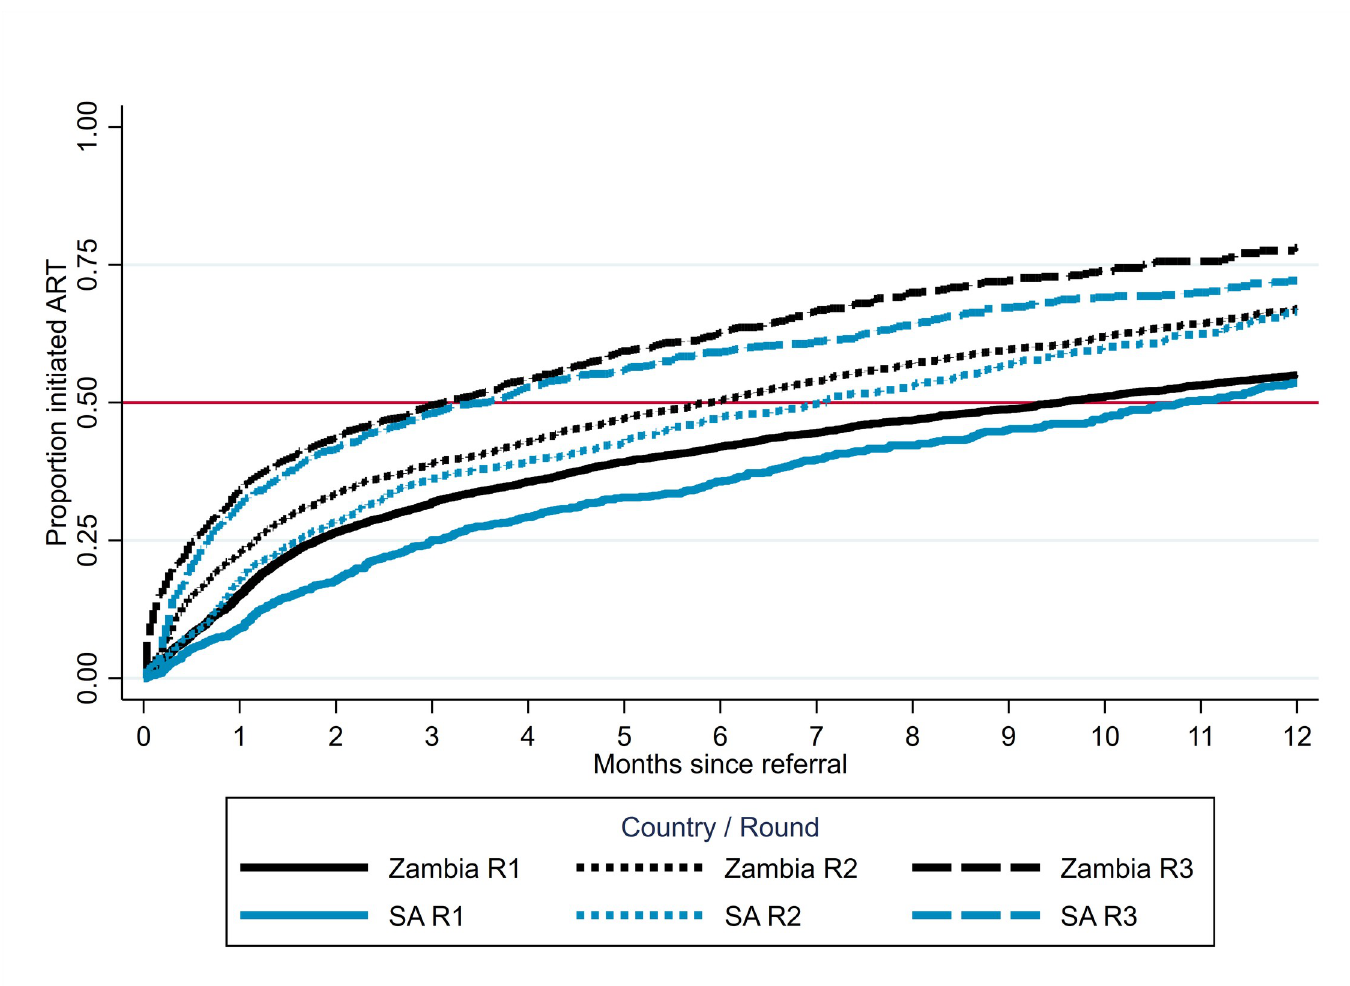
Fig 8. Arm A: Time from CHiP referral to ART initiation among individuals referred to HIV care, by country and round of referral. ART, antiretroviral therapy; CHiP, community HIV care provider; R1, Round 1; R2, Round 2; R3, Round 3; SA, South Africa.